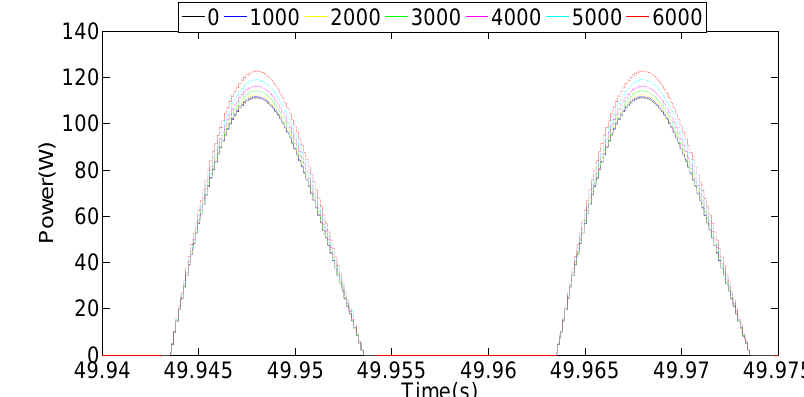
Figure 6. The IGBT power loss under different cycle times.